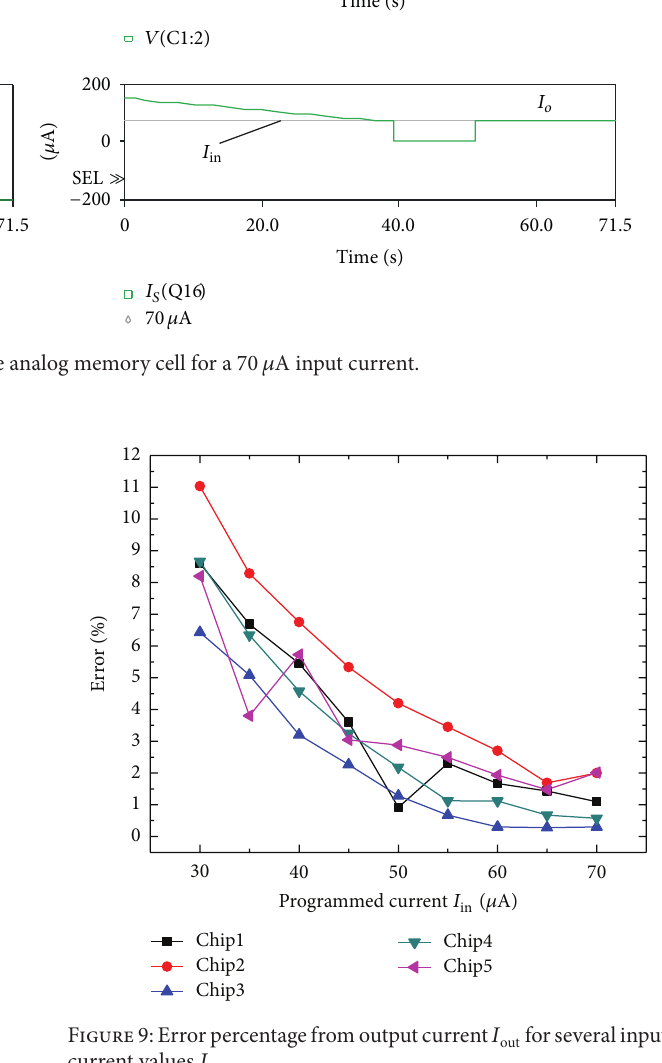
forseveralinput out